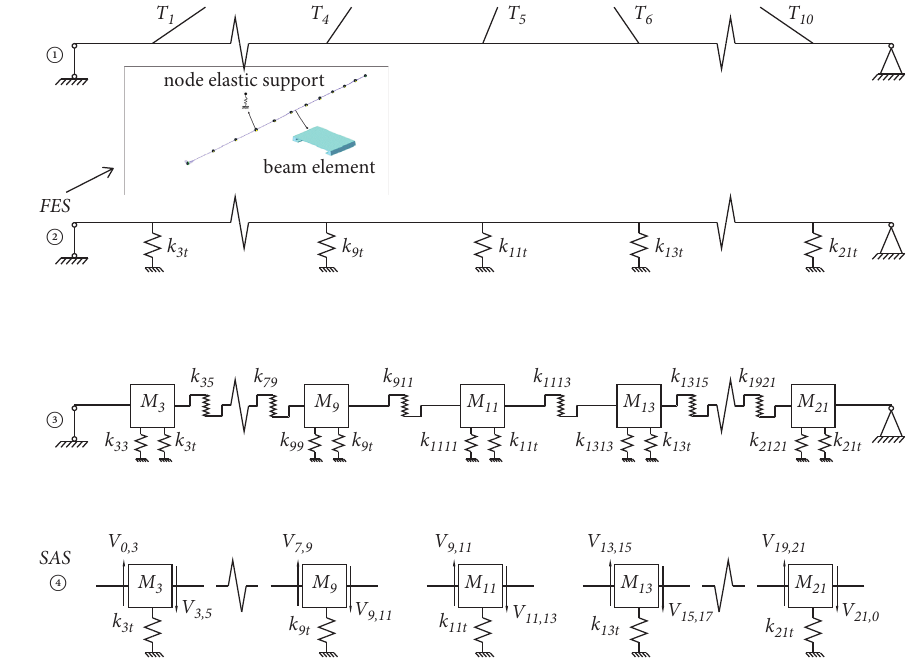
Figure 10: The simplified model of the single beam. Table 4: The model properties of the integrated system.